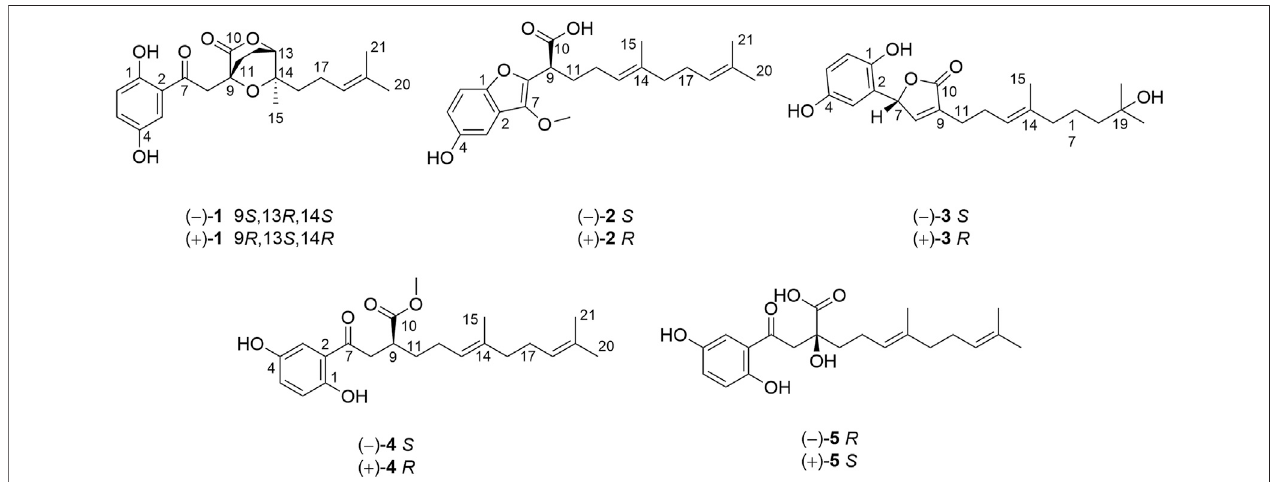
FIGURE 1 | Structures of 1 – 5 from Ganoderma lucidum .